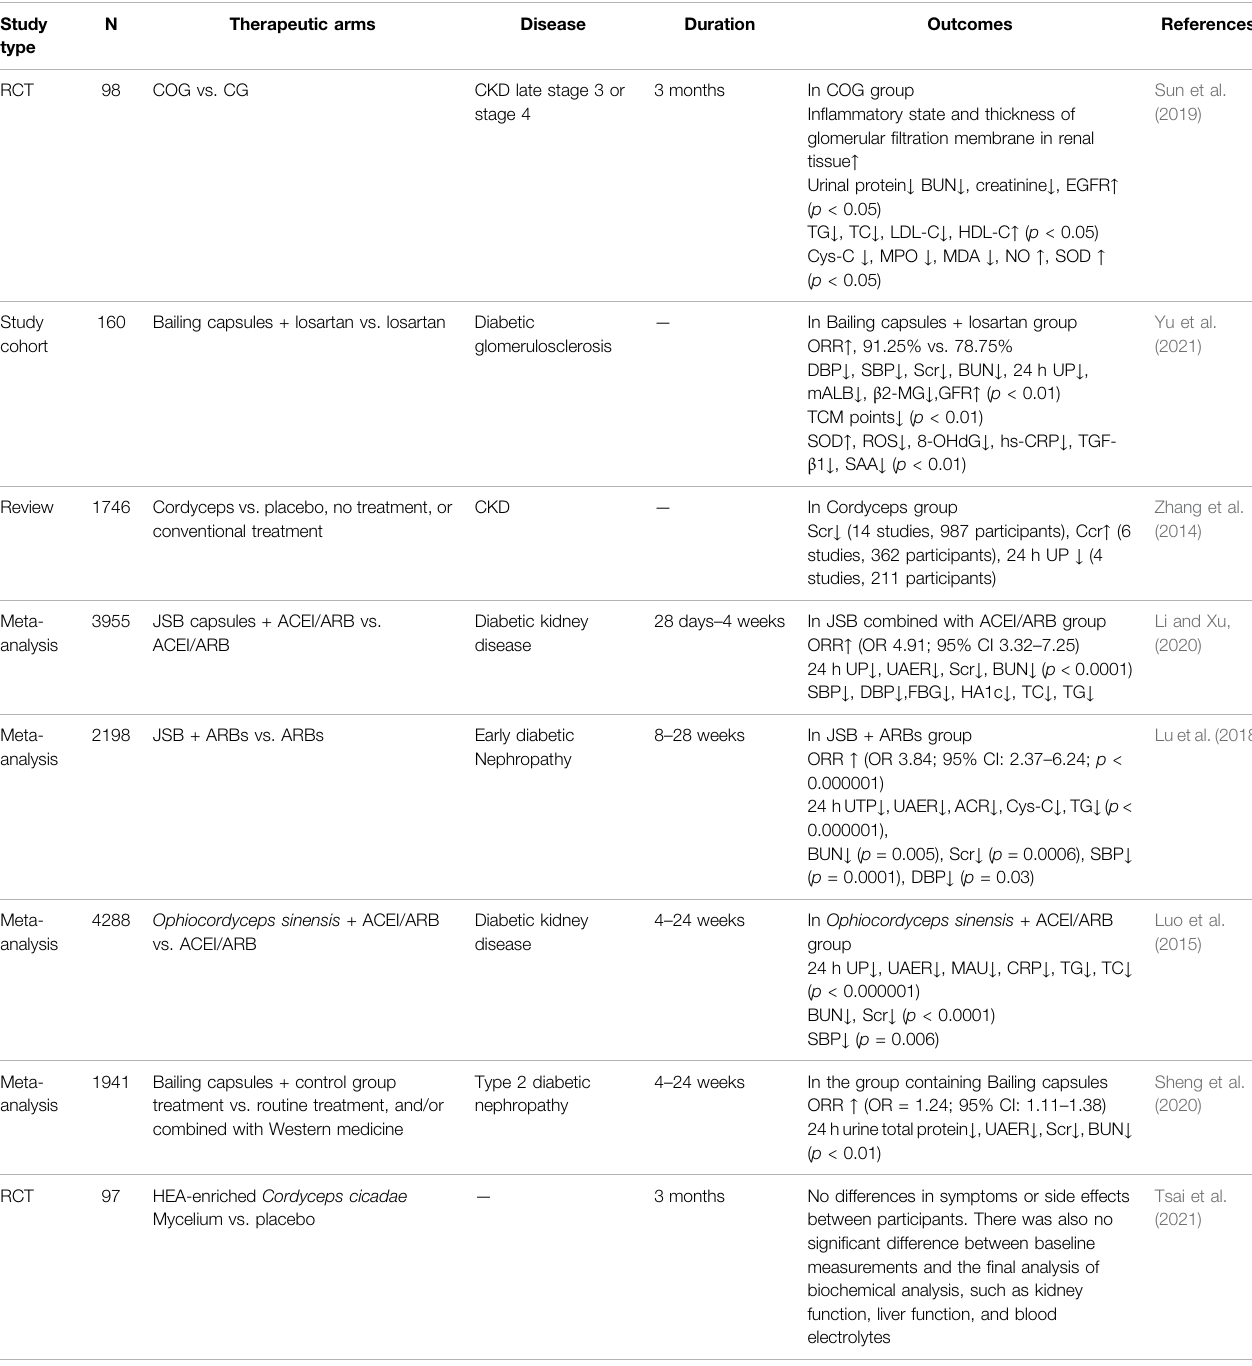
TABLE 2 | Clinical studies with